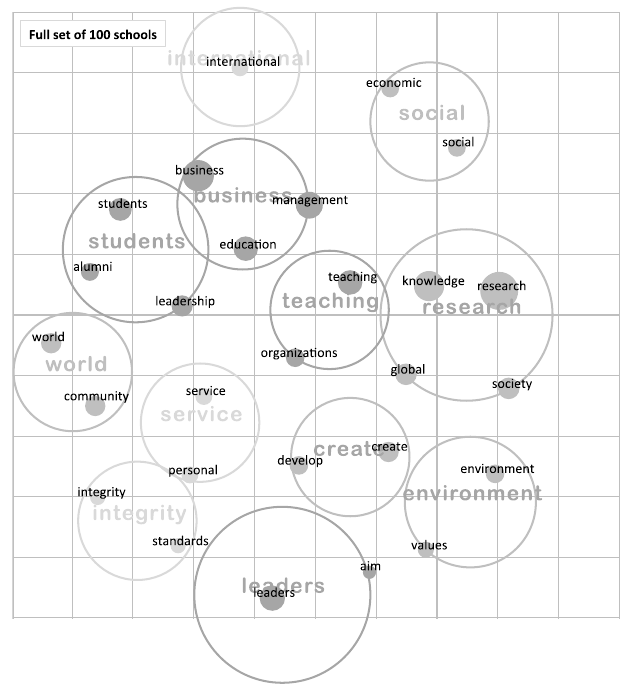
Figure 1: Leximancer™ maps for the 2009 financial times top 100 Business Schools